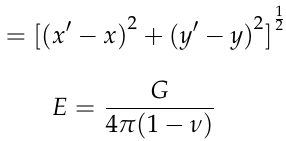
Figure 2. Fracture plane triangular mesh subdivision result diagram.